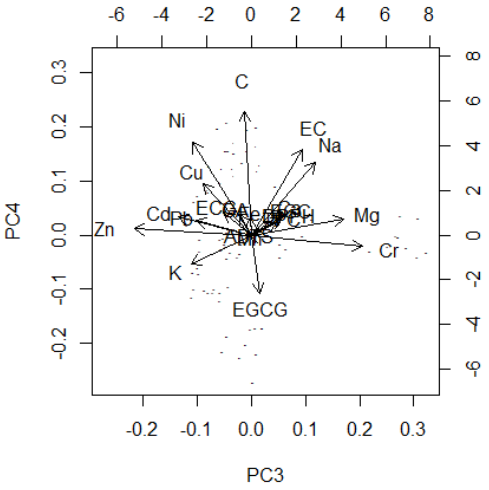
Figure 1. Biplots of Principal Component Analysis for tea dataset. This plot is discussed as loading values plot, scores are represented only as small dots to visualize shape of the dataset. The score plot without loadings, but with annotated teas is presented as Figure 2. GA — gallic acid; C — catechin; EGC — epigallocatechin; EGCG — epigallocatechin-3-gallate; ECG — epicatechin gallate; EC — epicatechin.